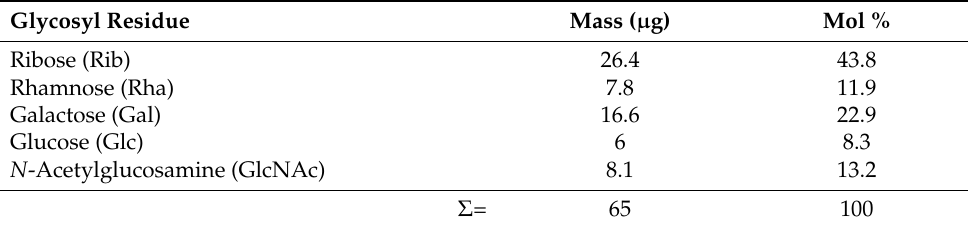
Figure 3. Composition analysis of the LPS from Lcr. GC/MS chromatogram of the fatty acids and carbohydrates released from the purified LPS via acid methanolysis and TMS derivatization. Table 1. Composition analysis of 200 µ g of the intact Lcr LPS.